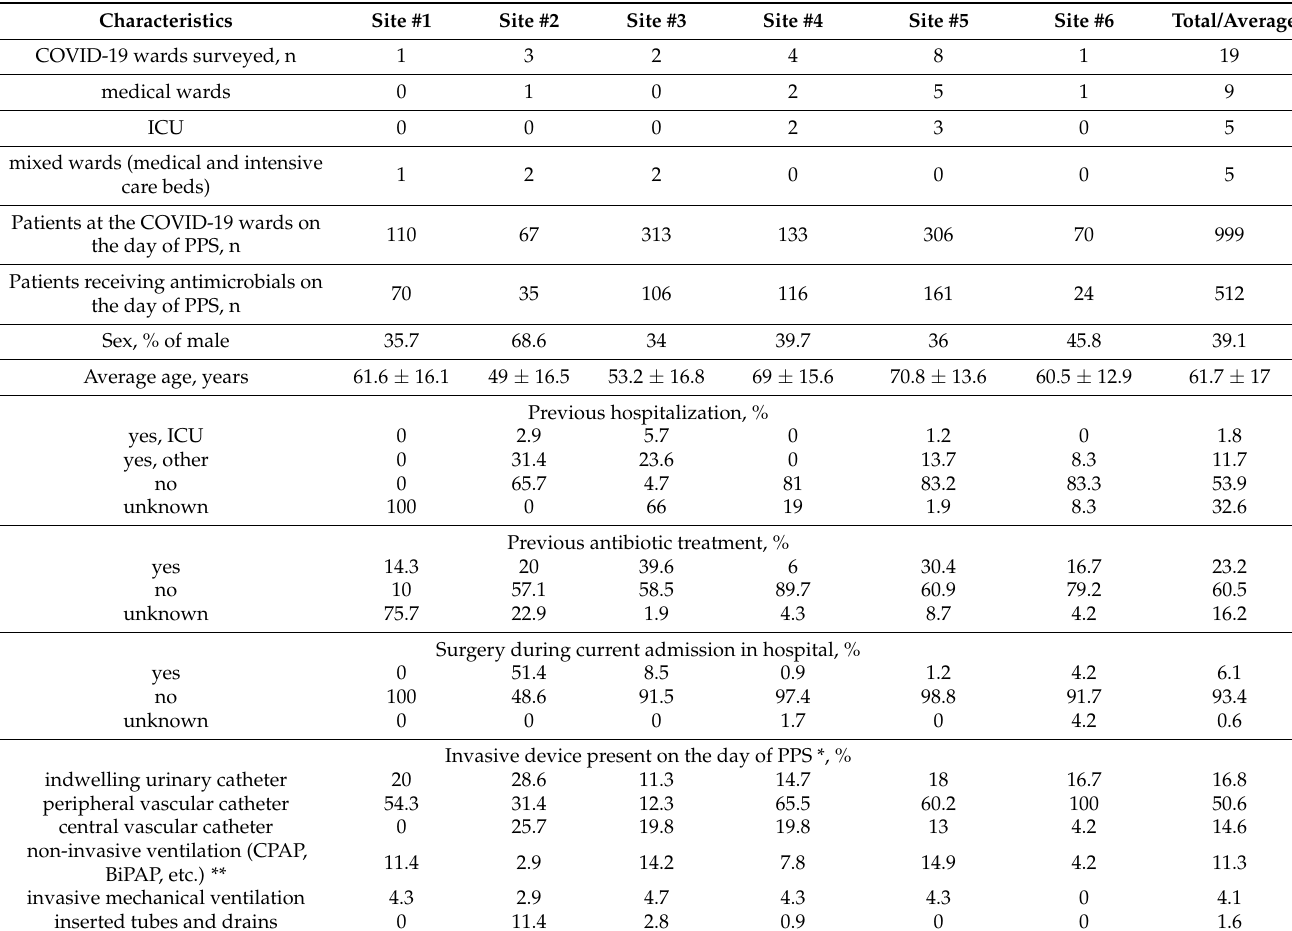
Table 1. Characteristics of the hospitals and detailed information on patients admitted to COVID-19 wards and treated with at least one